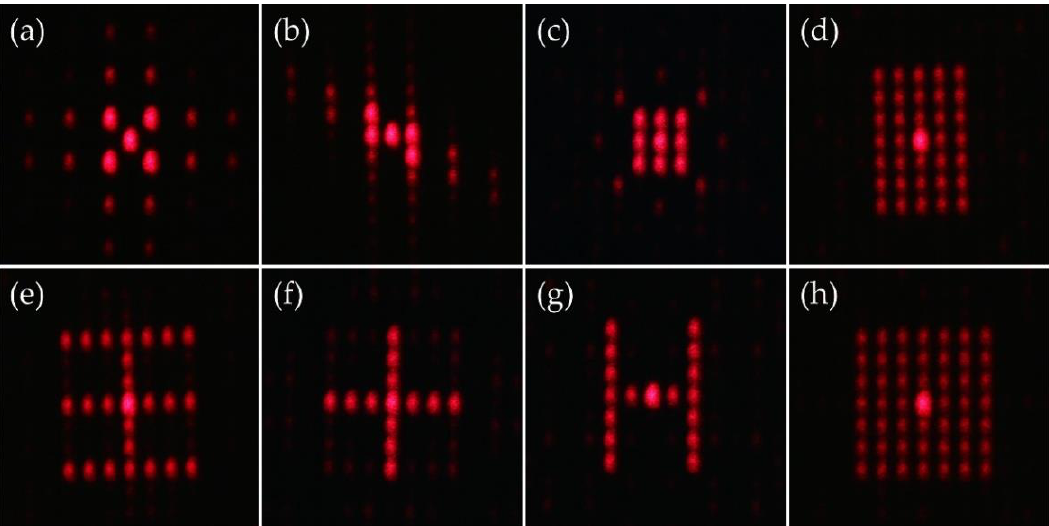
Figure 7. ( a ) mask and the fabricated DOEs; ( b )Experimental test system.